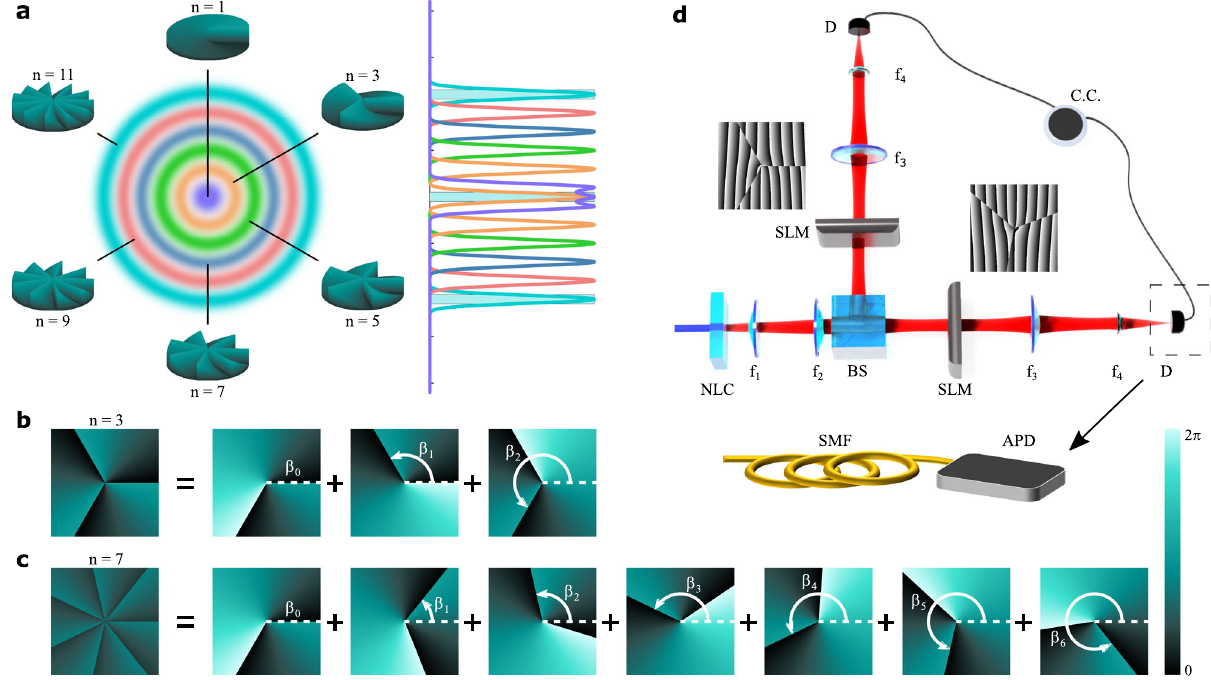
Fig. 1 Concept and implementation using OAM as an example. a Conceptual visualisation of different analysers sampling various portions of a high- dimensional discrete Hilbert space. Mode analysers construction for ( b ) n = 3 and ( c ) n = 7 superpositions of fractional OAM states, where β i is an orientation angle. d Schematic of the experimental set-up used to measure the dimensionality and purity of a quantum system. NLC non-linear crystal, f 1,2,3,4 lens, BS 50:50 beam splitter, SLM spatial light modulator, D detector, APD avalanche photodiode coupled to a single-mode coincidence